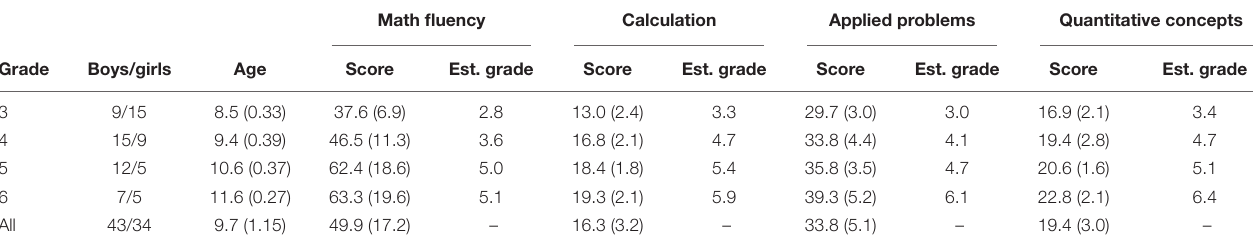
TABLE 1 | Descriptors for the children’s characteristics and the mathematical ability tests considered in this